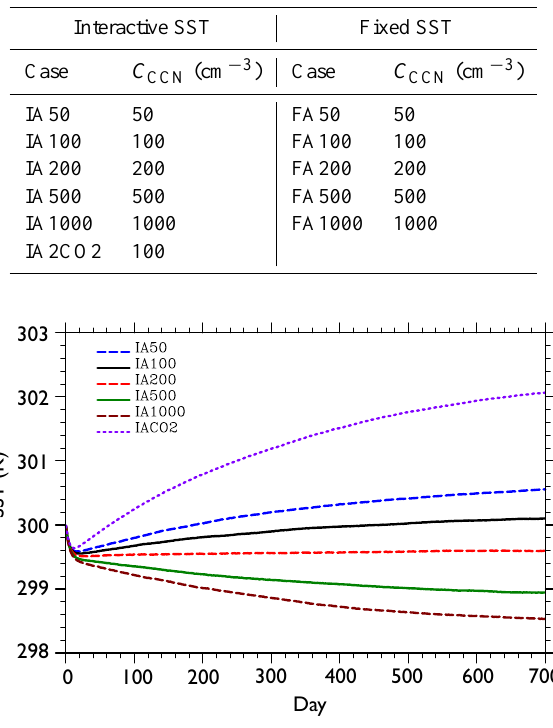
Table 1. List of simulations.